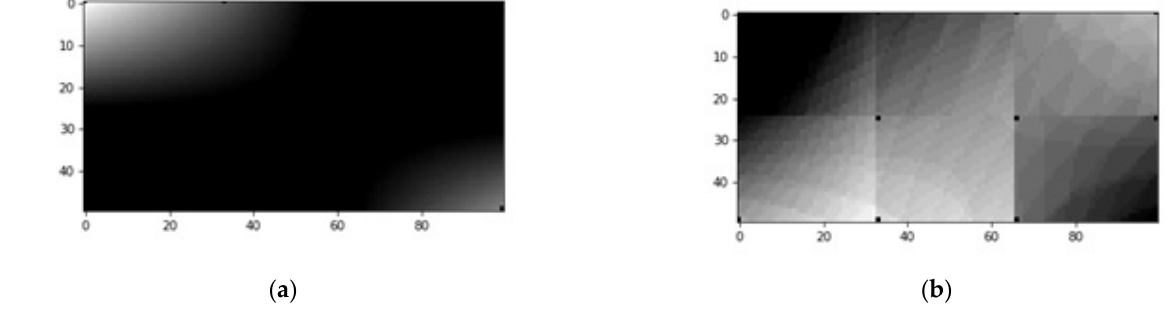
Figure 4. Bilinear interpolation, ( a ) sensors in corners, ( b ) sensors on walls and corners.